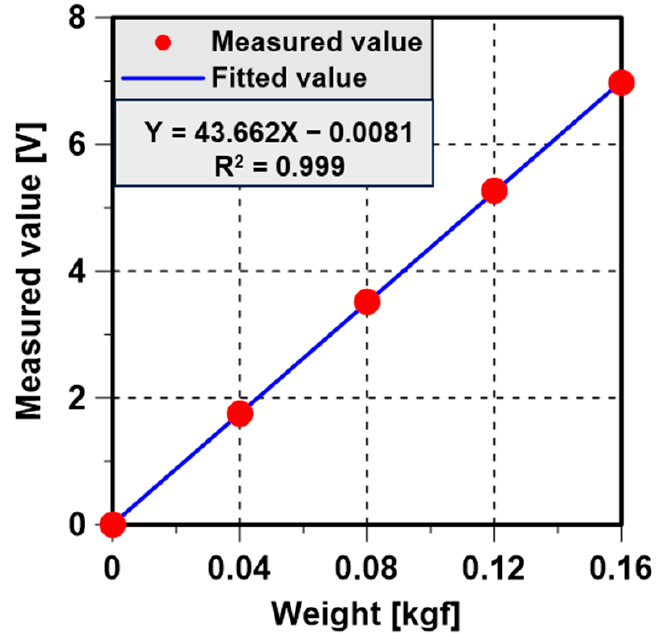
Figure 12. Experimental setup for resistance test.